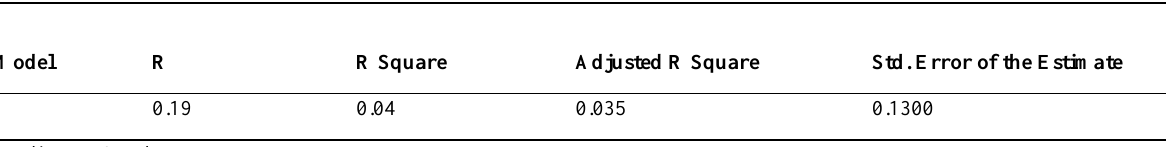
Table 3: Pearson Product Moment Correlation Analysis of the relationship between Gender and job satisfaction among early childhood educators in Cross River State, Nigeria